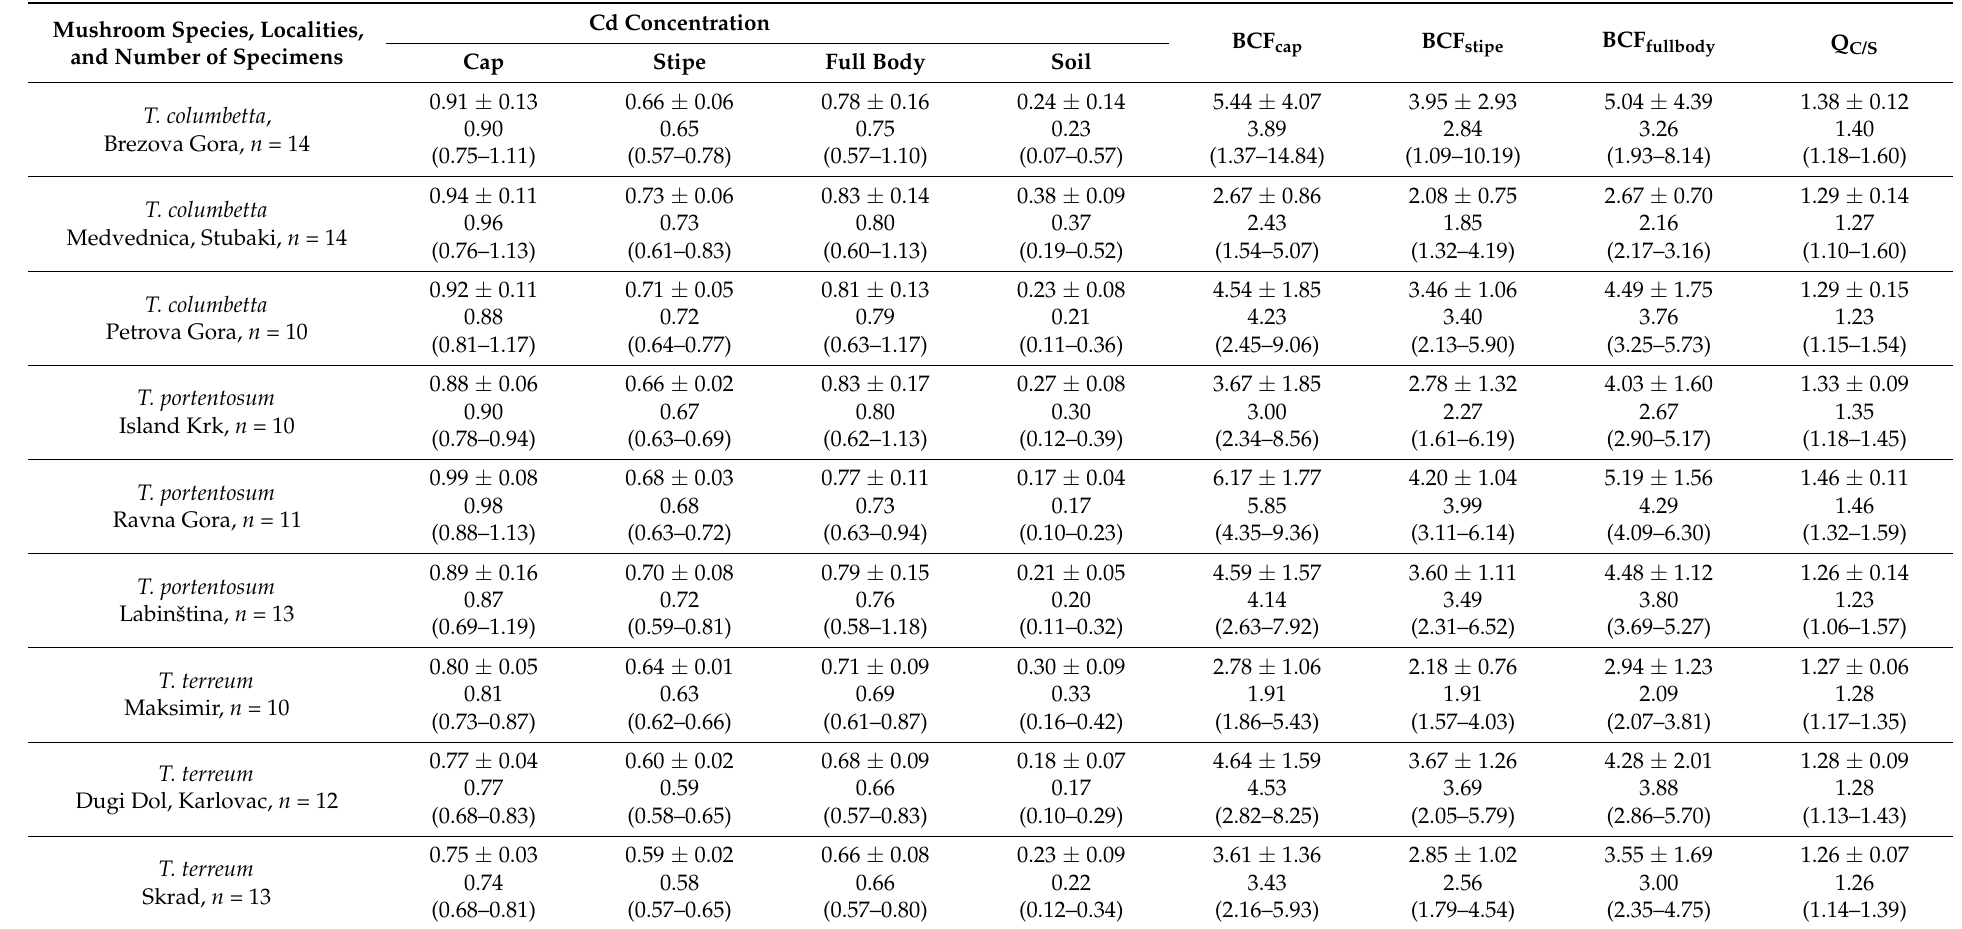
Table 2. Cadmium contents in Tricholoma spp. and related forest soil (mg/kg dry weight), Q C/S index, and BCF values (mean ± SD, median, and